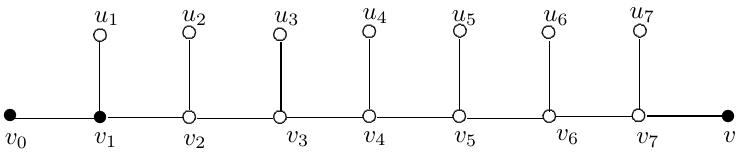
Figure 2: An ID-coloring of a caterpillar of diameter